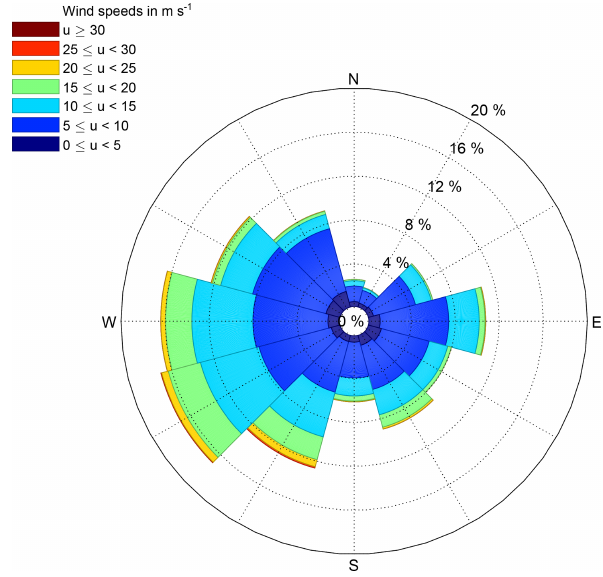
Figure 10. Site-specific wind rose calculated from free-stream SCADA